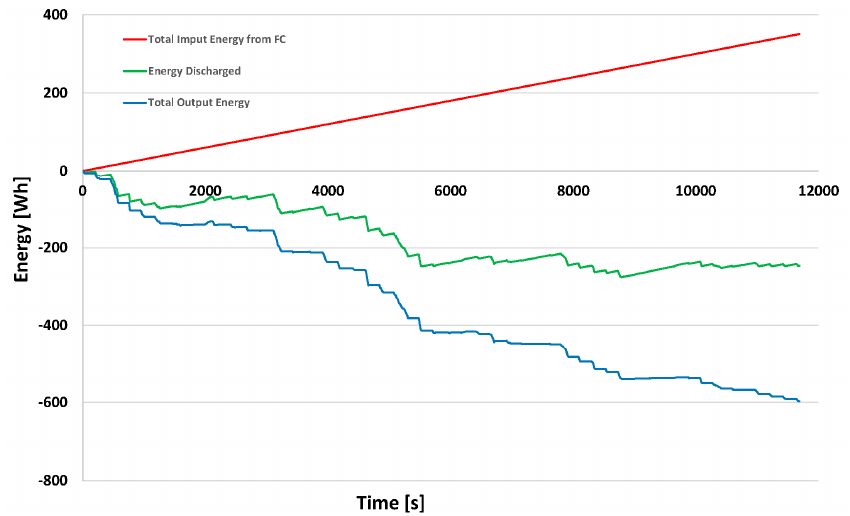
Figure 16. Instantaneous power of Traction Battery and Fuel Cell.